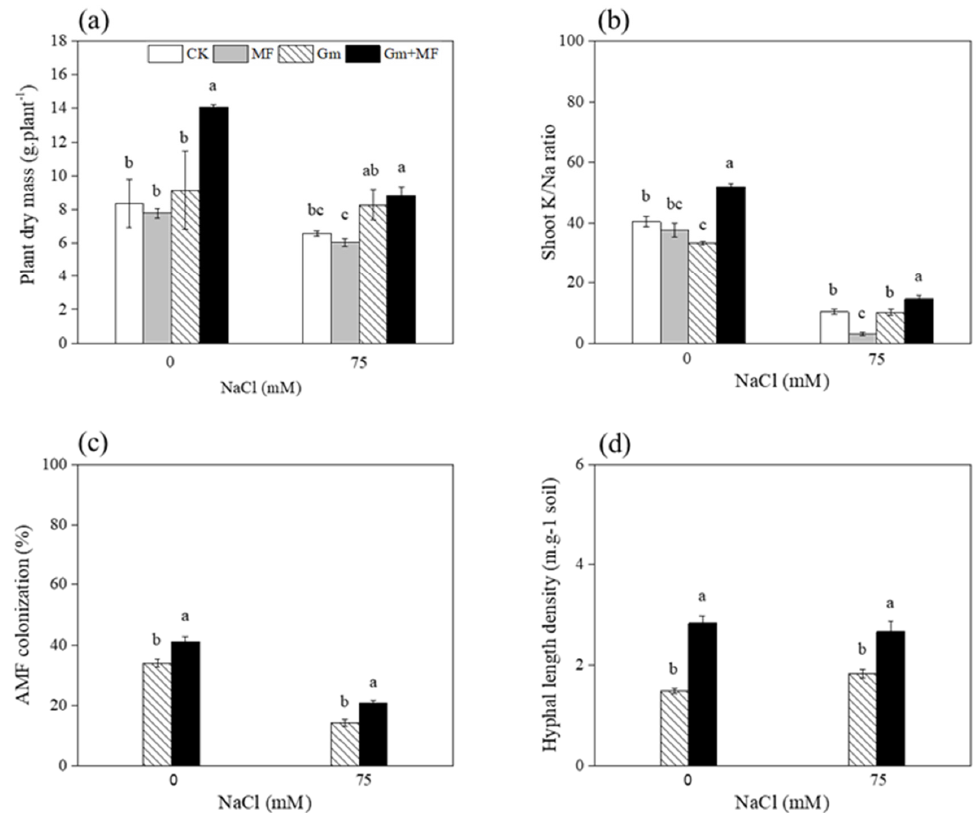
Figure 4. Effects of salinity levels (0 and 75 mM NaCl conditions) and inoculum types (CK, MF,